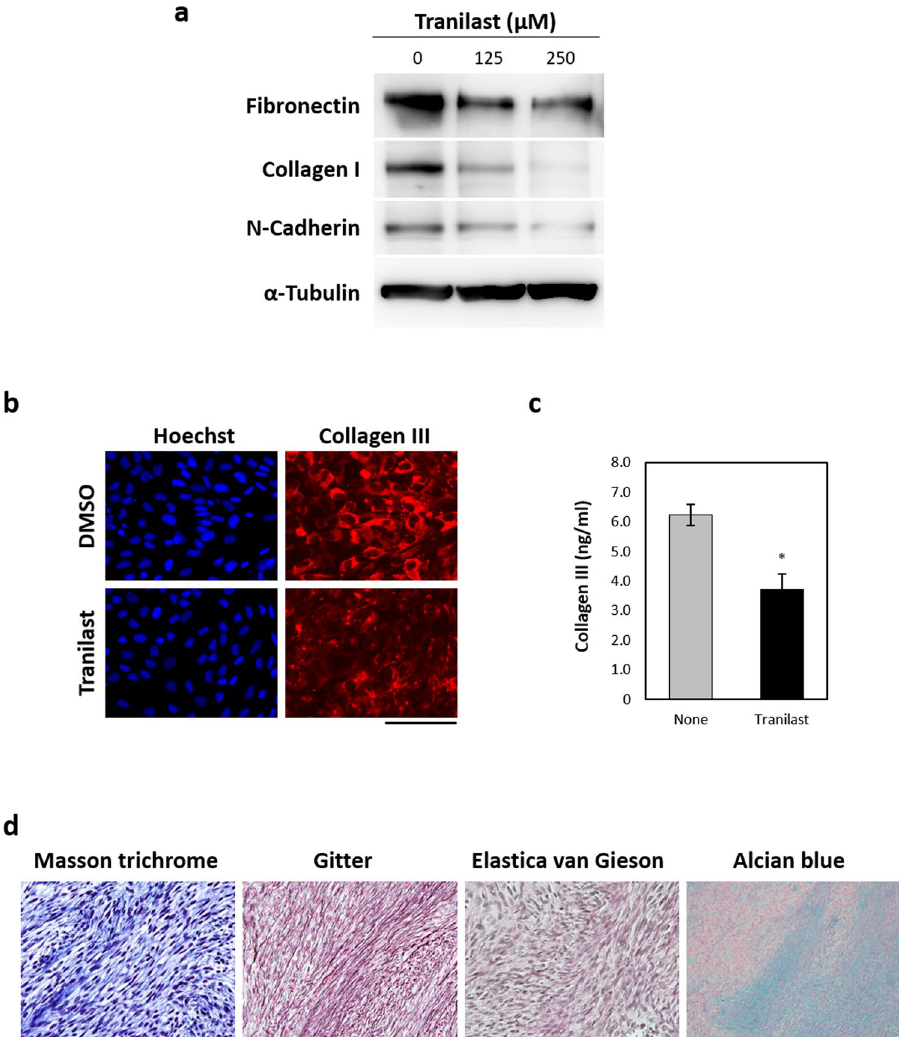
Figure 2. Tranilast attenuates the expression of mesenchymal markers in sNF96.2 cells. ( a ) Immunoblot analysis of fibronectin, collagen type I, N-cadherin, and α -tubulin (loading control) in sNF96.2 cells treated with the indicated concentrations of tranilast for 48 h. Blots are derived from different regions of the same gel. Uncropped images are shown in Supplementary Fig. S6. ( b ) Immunofluorescence analysis of collagen type III in sNF96.2 cells treated with tranilast (250 µ M) or dimethyl sulfoxide (DMSO) vehicle for 48 h. Nuclei were stained with Hoechst 33342. Scale bar, 100 µ m. ( c ) Quantification by ELISA of collagen type III in sNF96.2 cells incubated with or without tranilast (250 µ M) for 48 h. Cell lysates were assayed. Data are means ± s.d. for duplicates from a representative experiment. * P < 0.05 versus control (Student’s unpaired t test). ( d ) Tumours formed by injected sNF96.2 cells in the brain of NOD/SCID recipient mice were subjected to histological analysis by Masson’s trichrome, Gitter, Elastica van Gieson, and Alcian blue